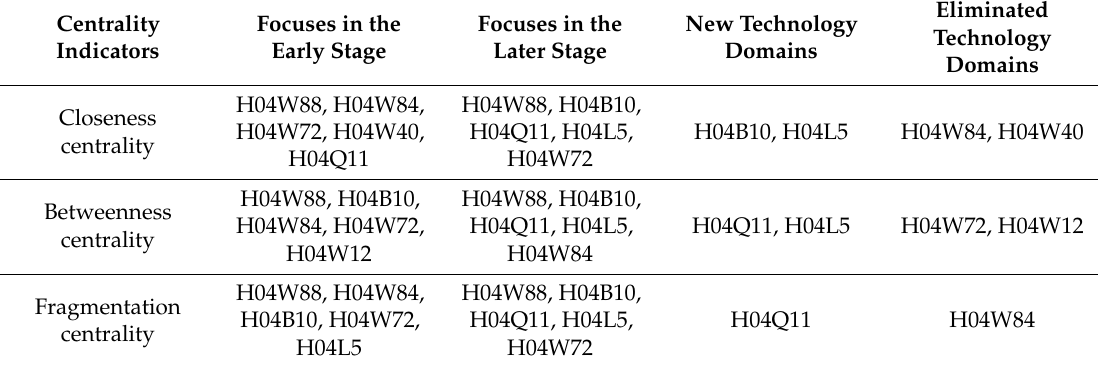
Table 5. Key trends in technical developments for 5G optical